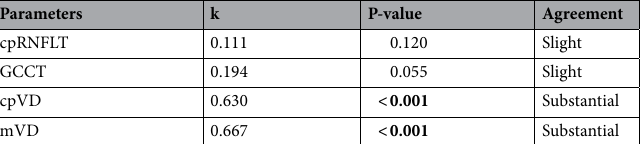
Table 4. Agreement between VF progression and OCT/OCTA-derived parameters’ progression determined by the event-based analysis using kappa agreement statistics. cpRNFLT circumpapillary retinal